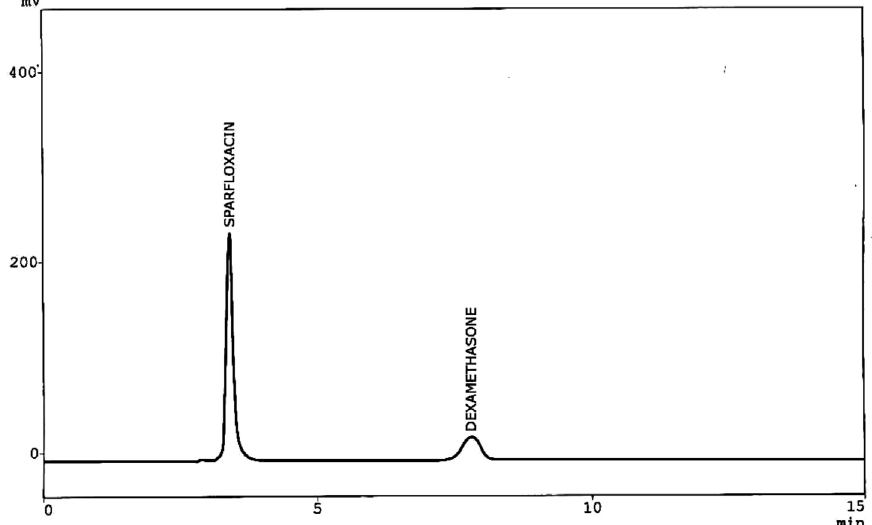
= 3.415) and dexamethasone (t = 7.792) in pharmaceutical formulations. FIGURE 2 - Chromatogram of sparfloxacin (t R R Chromatographic conditions: mobile phase methanol: 0.02 M phosphate buffer (60:40, v/v), pH 3.0, Column BDS Hypersil C8 (250 X 4.6, 5µm), flow rate 1.5 mL min -1 , injection volume 20 µL, wavelength 270 nm. Concentration: 60 µg/mL sparfloxacin and 20 µg/mL